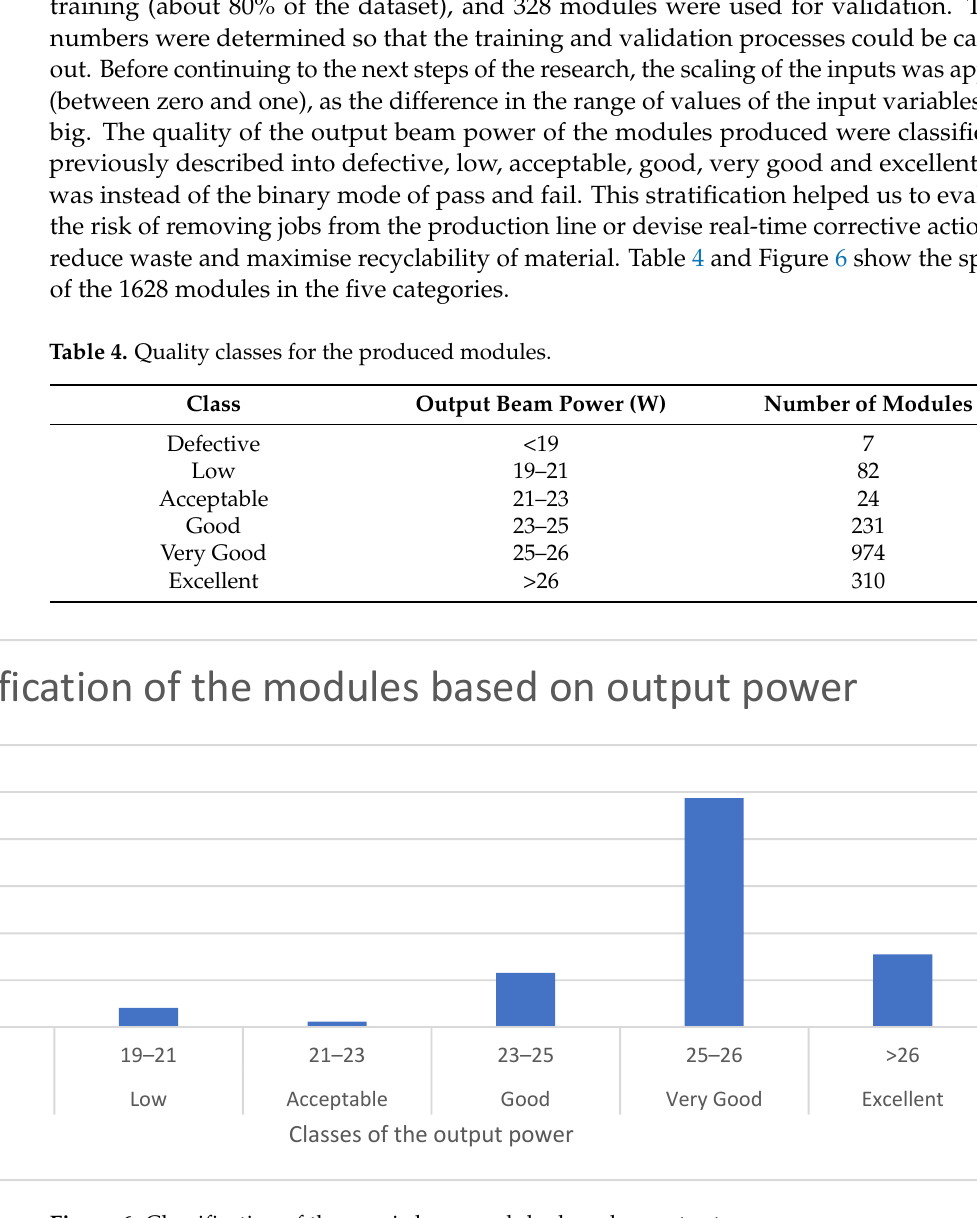
Figure 6. Classification of the s-serie laser modules based on output power.